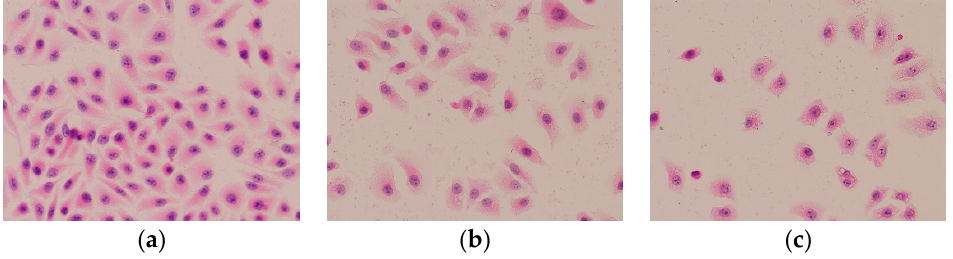
Figure 8. Effect of EPS-3a induced HepG2 cells apoptosis by HE staining (40×). Cells were treated with EPS-3a for different time (24 h, 48 h and 72 h). The concentration of EPS-3a was 313.75 μ g/mL. ( a ) Control, 0 h. ( b ) Cells treated with EPS-3a for 24 h. ( c ) Cells treated with EPS-3a for 48 h.